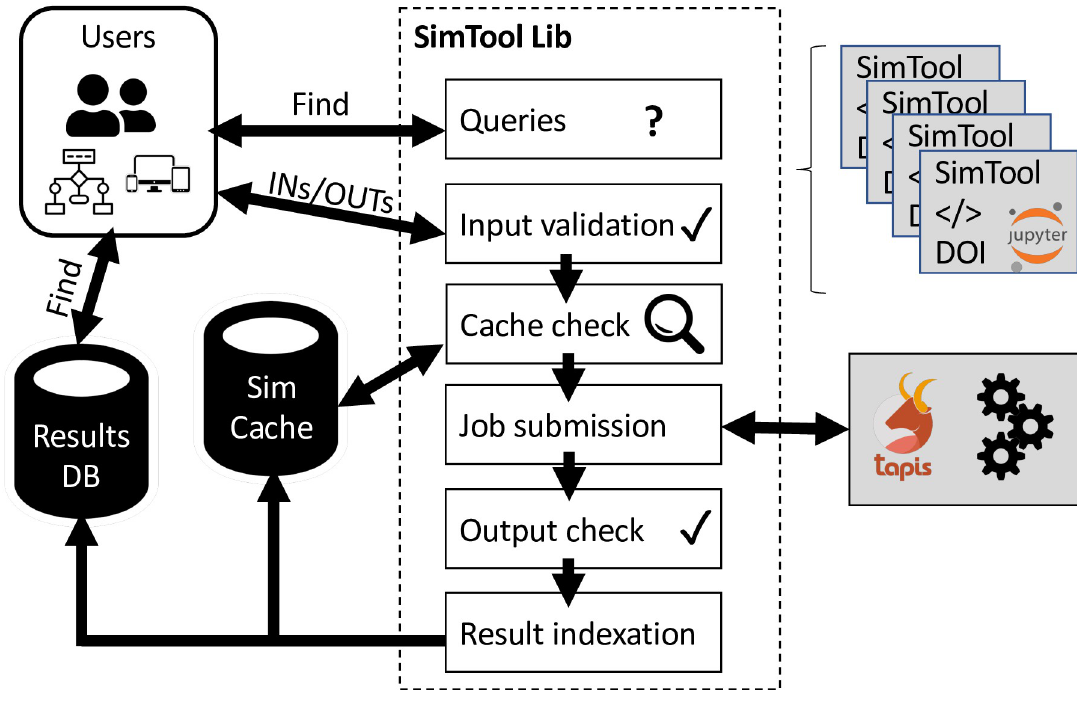
Fig 1. Simtool ecosystem